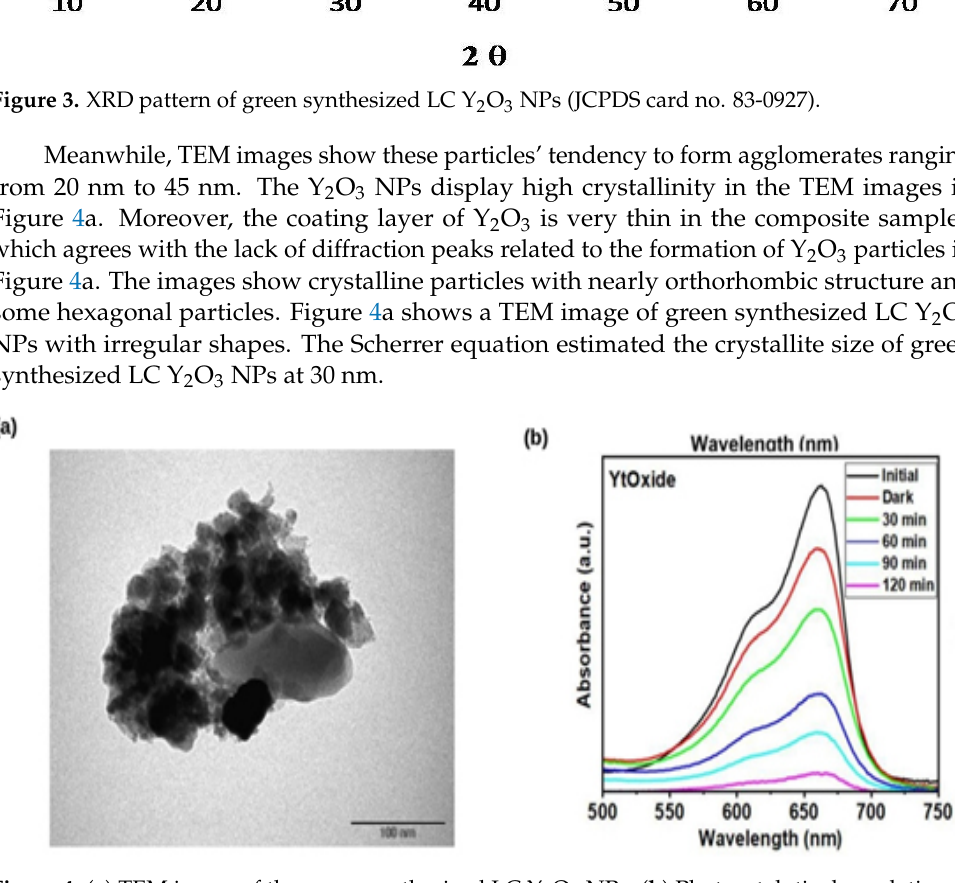
Figure 4. ( a ) TEM image of the green synthesized LC Y 2 O 3 NPs. ( b ) Photocatalytic degradation of Rhodamine B utilizing the green synthesized LC Y 2 O 3 NPs.